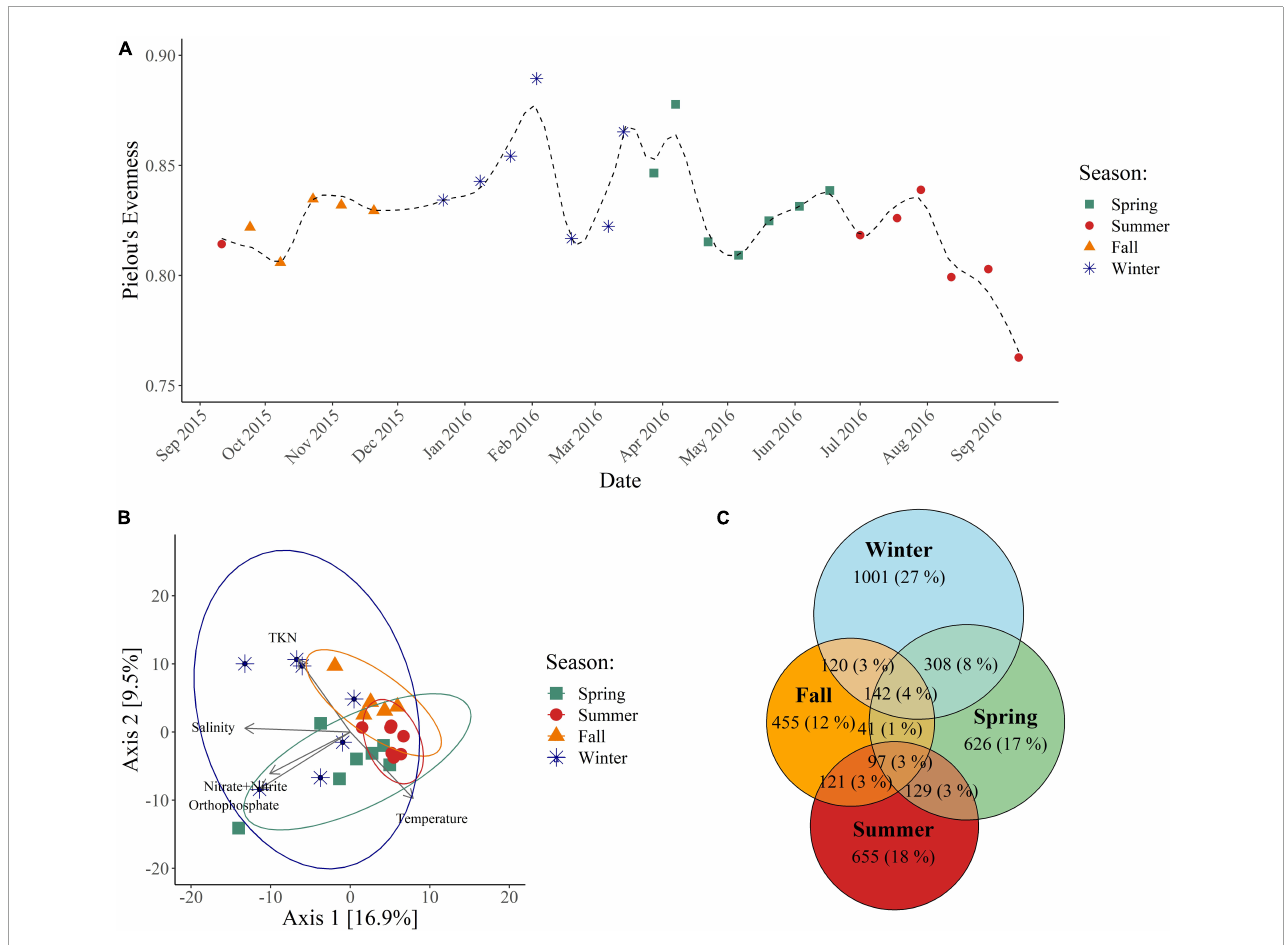
FIGURE2 Bacterial alpha-diversity and community structure. (A) Alpha-diversity calculated from the rarefied ASV count table using Pielou’s evenness index. (B) PCA constructed from the variance stabilizing transformed ASV count table. Ellipses represent the 95% confidence interval. (C) Euler diagram constructed from the rarefied ASV count